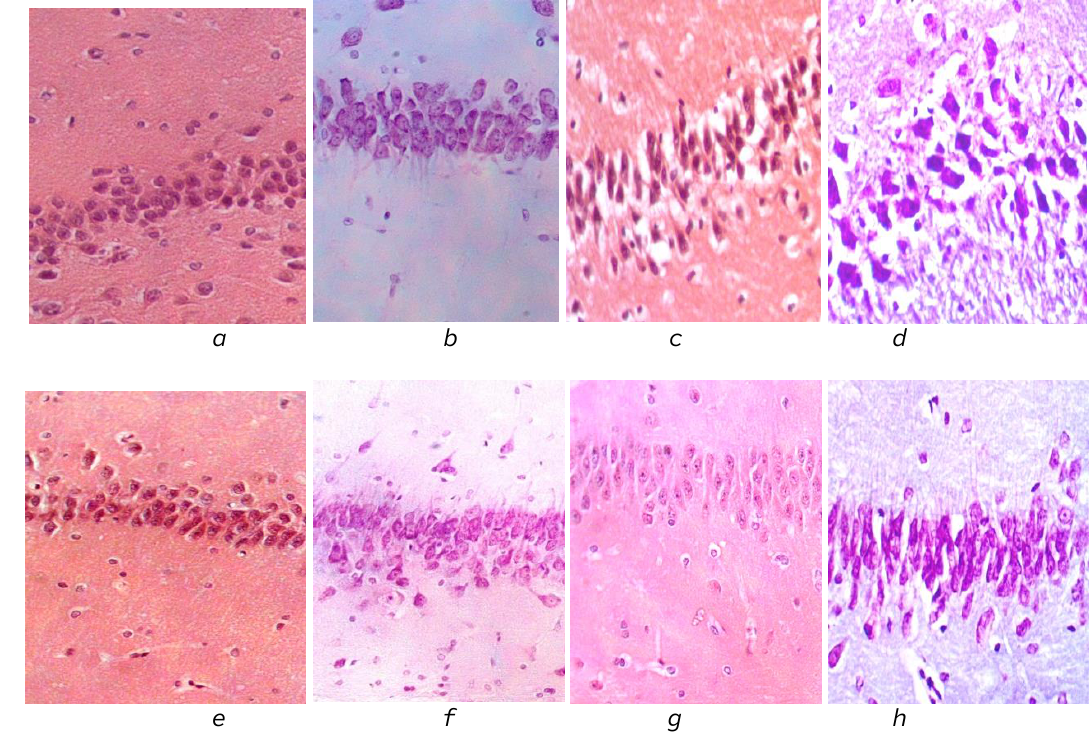
Fig. 1. Zone CA of the ventral hippocampus: a, b: pseudo-operated animals: a – rows of neurons of round shape 1 (hematoxylin-eosin. ×250); b – the state of the tigroid substance in the neuroplasm of the vast majority of neurons corresponds to normal (thionin by the method of Nissl. ×250); c, d – rats with ACVA for 6 days after modelling (c – disorganization, decrease in the density of neurons, “loss” of cells from the rows, pericellular edema, d – the predominance of hyperchromic and hyperchromic pycnomorphic neurons (thionine by the method of Nissl. ×250); e, f – rats with ACVA, which were treated with the compound KGM-5 (30 mg/kg) (e – restoration of the architecture of the series, the density of neurons in the series (hematoxylin-eosin. ×250), f – the state of the tigroid in the neuroplasm of the vast majority of cells normal (thionin by the method of Nissl. ×400); f, g – rats with ACVA, which were treated with CD “Picamilon” (17 mg/kg): g – restoration of the structure of the pyramidal layer (hematoxylin-eosin. ×250), h – normochromic and hyperchromic neurons (thionine by the method of Nissl. ×400) Against the background of treatment of KGM-5 as the area of the perikaryon of neurons, were close to rats with ACVA, it was found that in the CA zone of the the values of POA (Table1, 2). In the CA zone of the 1 3 hippocampus, the width of the pyramidal layer was hippocampus of rats with ACVA treated with the restored in most areas, the density of neurons in the row compound KGM-5, some areas containing neurons with was significantly increased, the order of the rows was signs of dystrophic changes, cell prolapse were detected also restored. Most neurons had a characteristic shape (Fig. 2, d ). During thionine staining, almost the entire that was identical to that in POA (Fig. 1, d, e ). In some spectrum of functional states of pyramidal neurons was places, pericellular edema was preserved. Morphometric detected (Fig. 2, e ). The alteration index was at the level parameters in the CA zone of the hippocampus, as well of CP 1